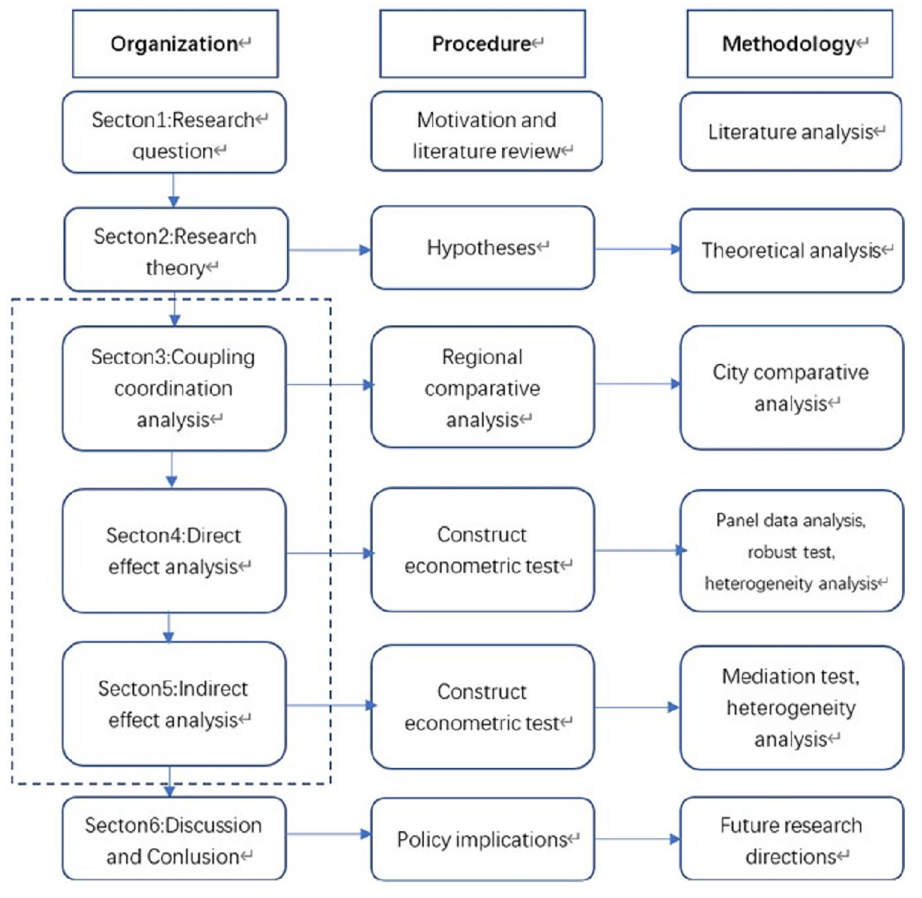
Fig 1. Logic of this